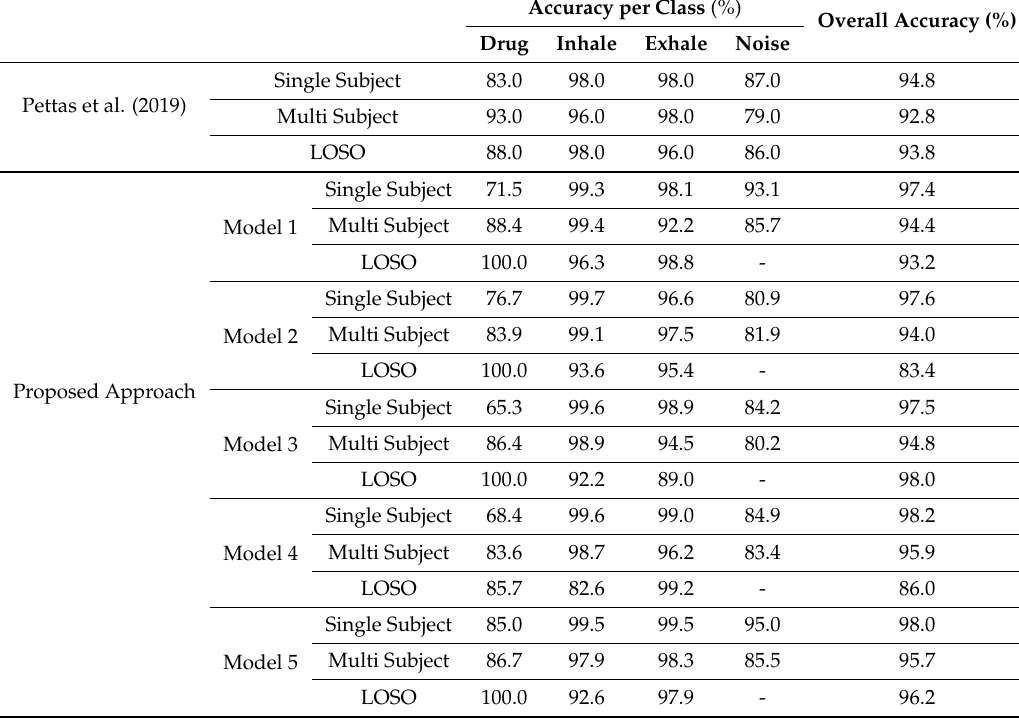
Table 3. State of the Art with all validation